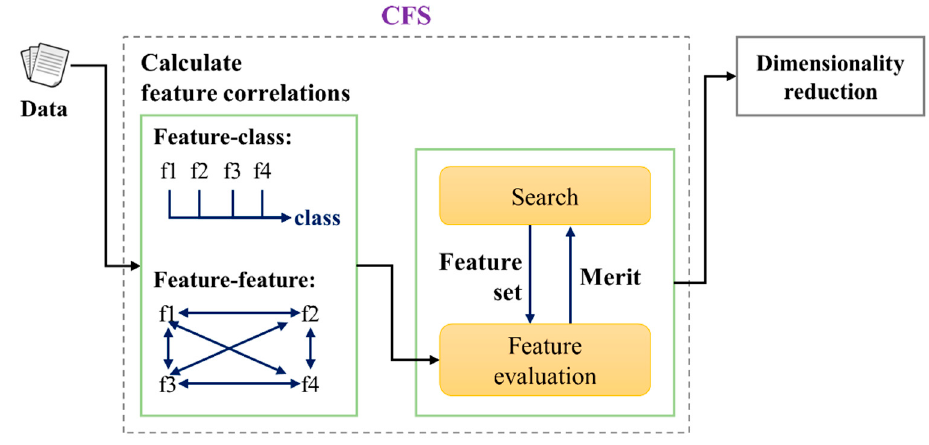
Figure 3. Feature dimensionality reduction by CFS [20].